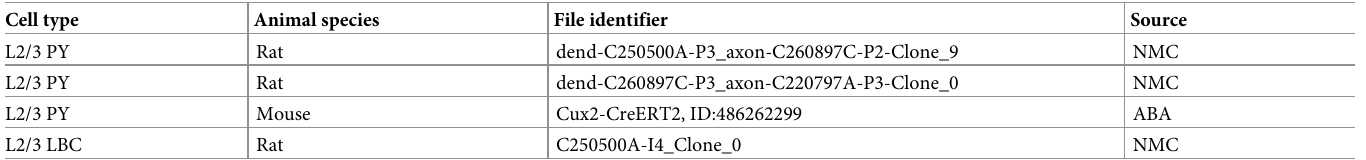
Table 5. Morphologies types and file identifiers used in the multicompartment neuron network model. Cell type Animal